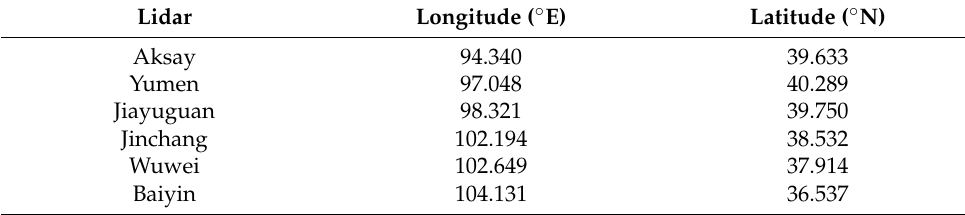
Figure 1. The Lidars distribution. The black circles represent the deserts around the Lidar network, the green lines represent the Lidar stations, the white dots represent the locations of the cities examined in the dust process besides the six Lidars stations, the red lines represent the provincial boundaries. Table 2. Location of Lidars.